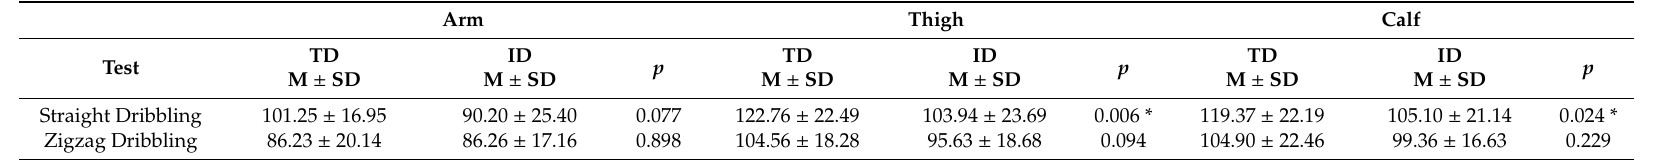
Table 10. ANOVA results of the limb swinging frequency (swings / minute) in the two groups. Thigh